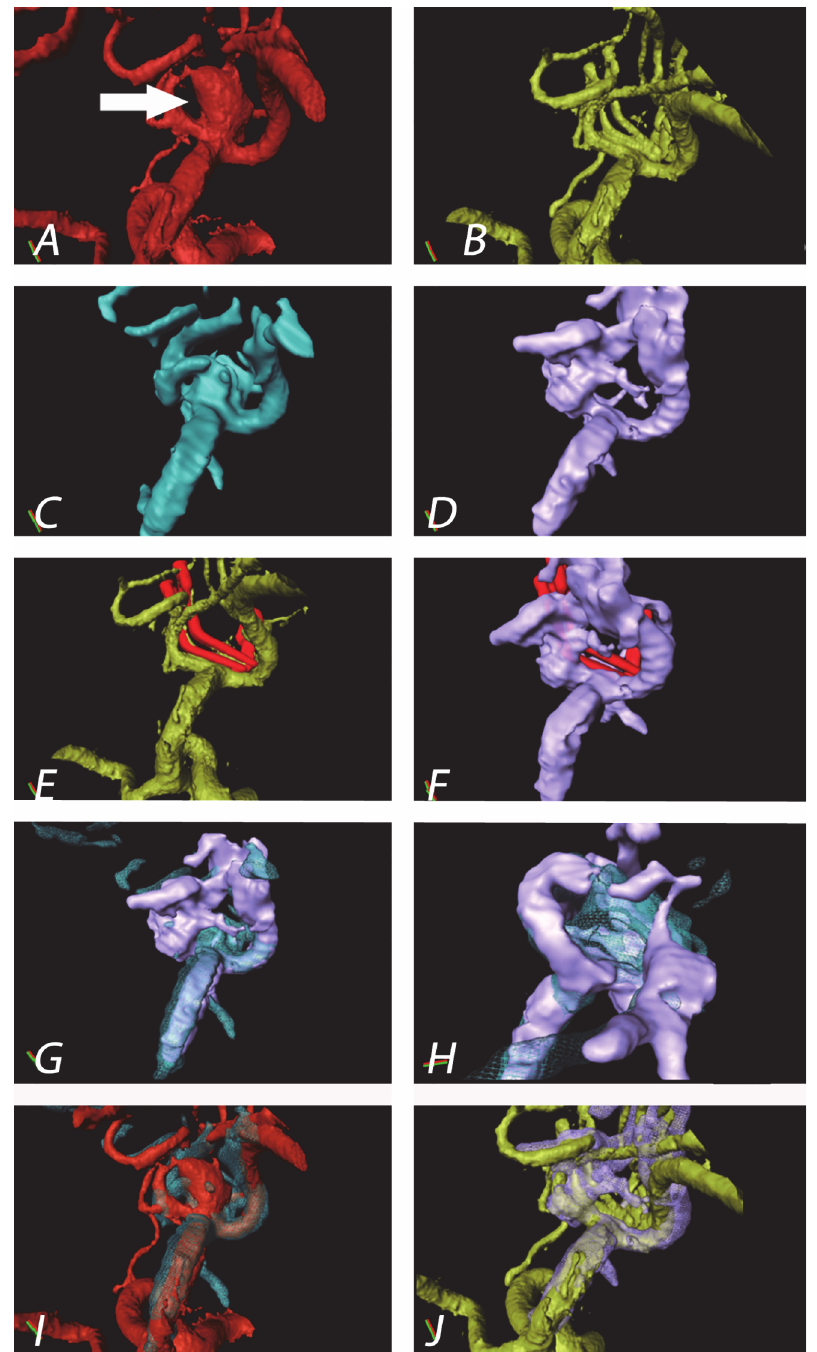
Fig 6. Patient 4: Aneurysm of the medial cerebral artery bifurcation indicated by the white arrow. Precise aneurysm neck visualization in 3D-ioUS and clip segmentation for virtual planning of clipping procedure. A : pre-clipping rDSA (red); B : post- clipping rDSA (green); C : pre-clipping 3D-ioUS (blue); D : post- clipping 3D-ioUS (pink); E : post- clipping rDSA with segmented clips (red); F : post- clipping 3D-ioUS with segmented clips (red); G — H : coregistration of C+D; I: coregistration of A+C; J : coregistration of B+G.